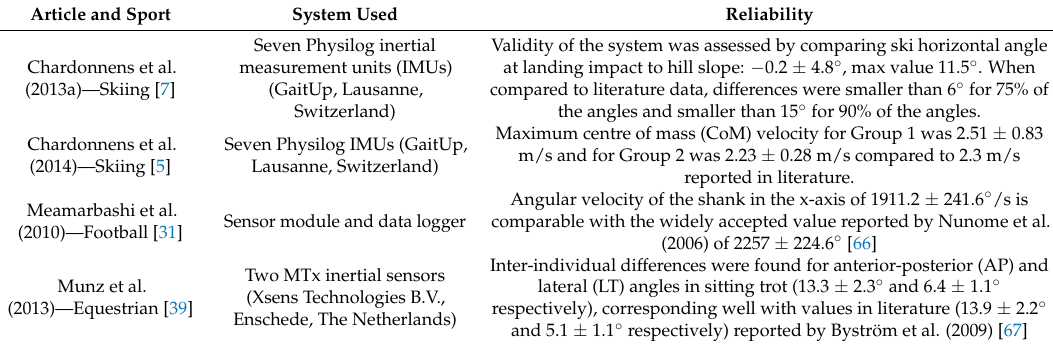
Table 6. Wearable systems compared to values reported in